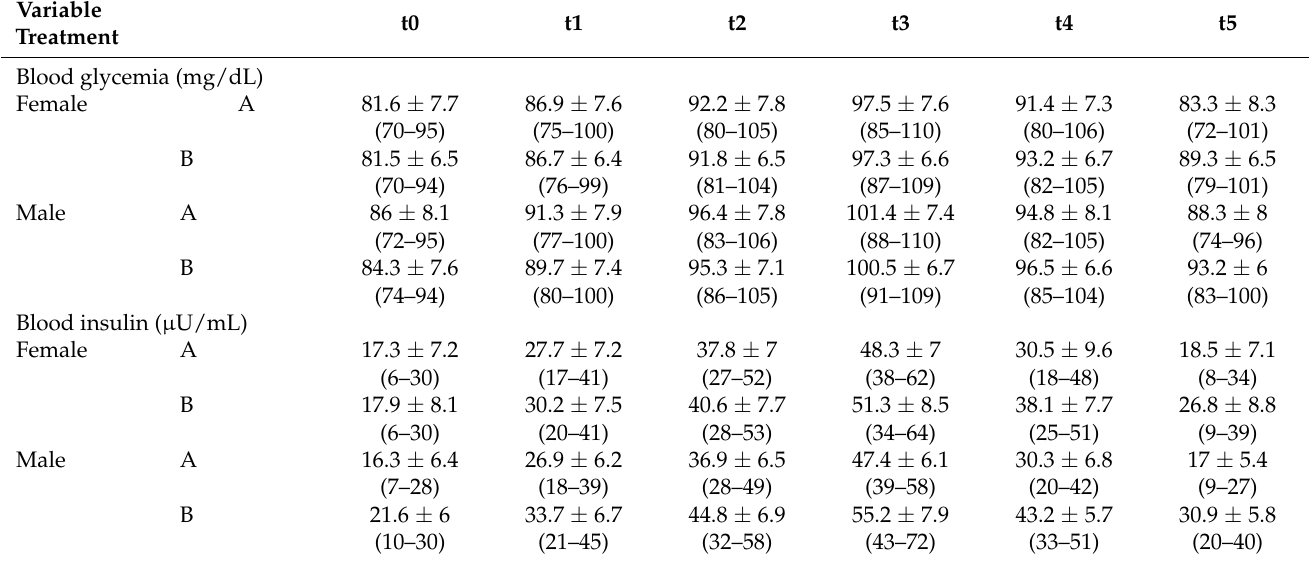
Table 4. Variation in values (mean ± standard deviation, minimum and maximum) of blood glucose and insulin in men and women for the two experimental treatments (A: BSG extract-based food supplement, and B: